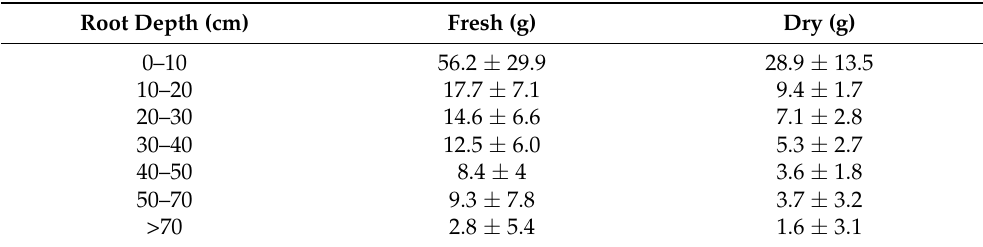
Table 2. Mean fresh and dry root biomass production for the seven root depth increments of a 1.0 m